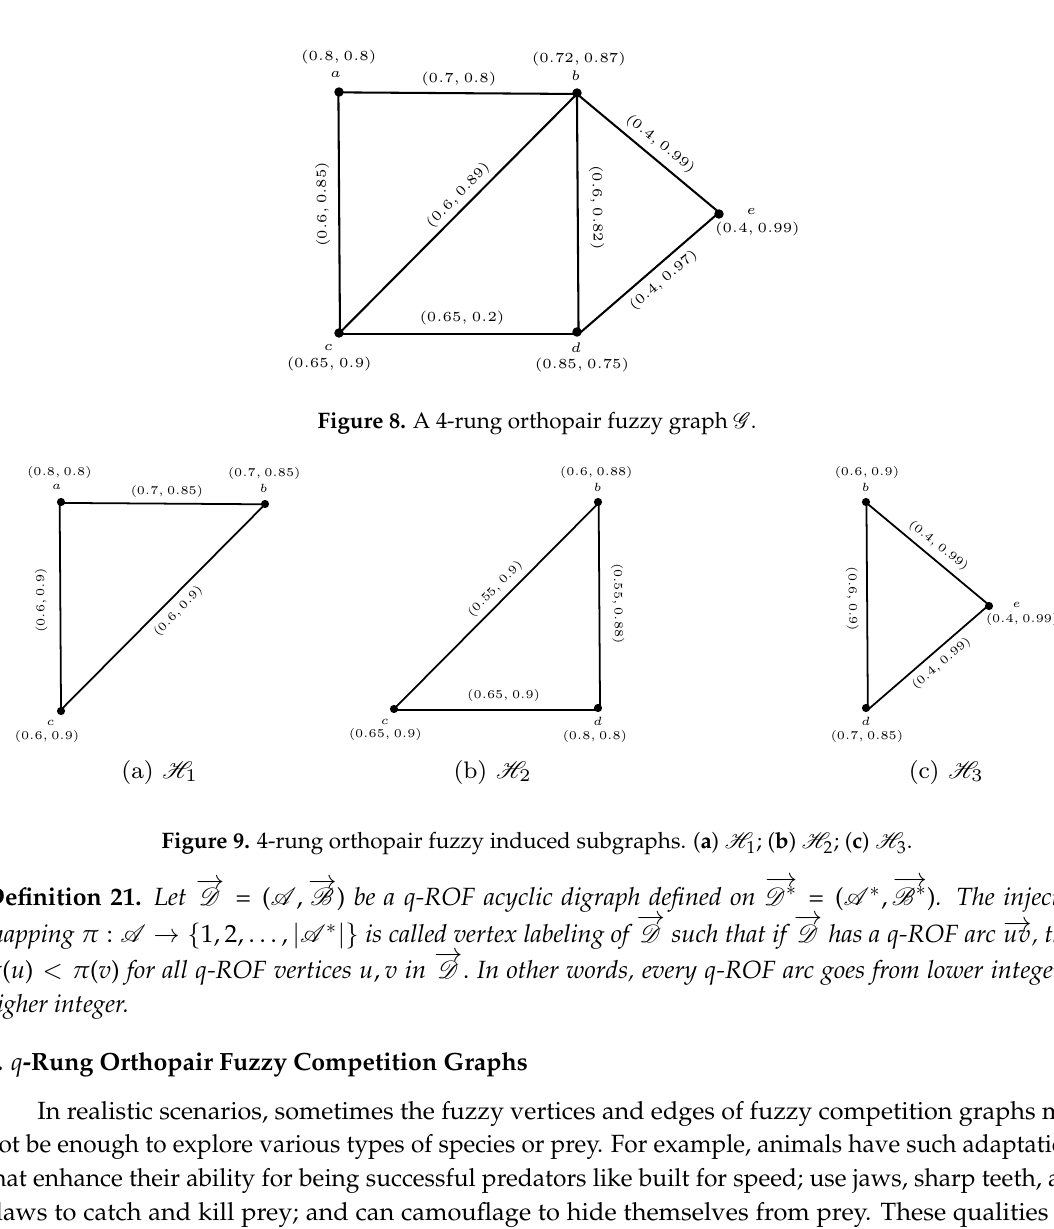
Figure 3.7: 4-rung orthopair fuzzy induced subgraphs